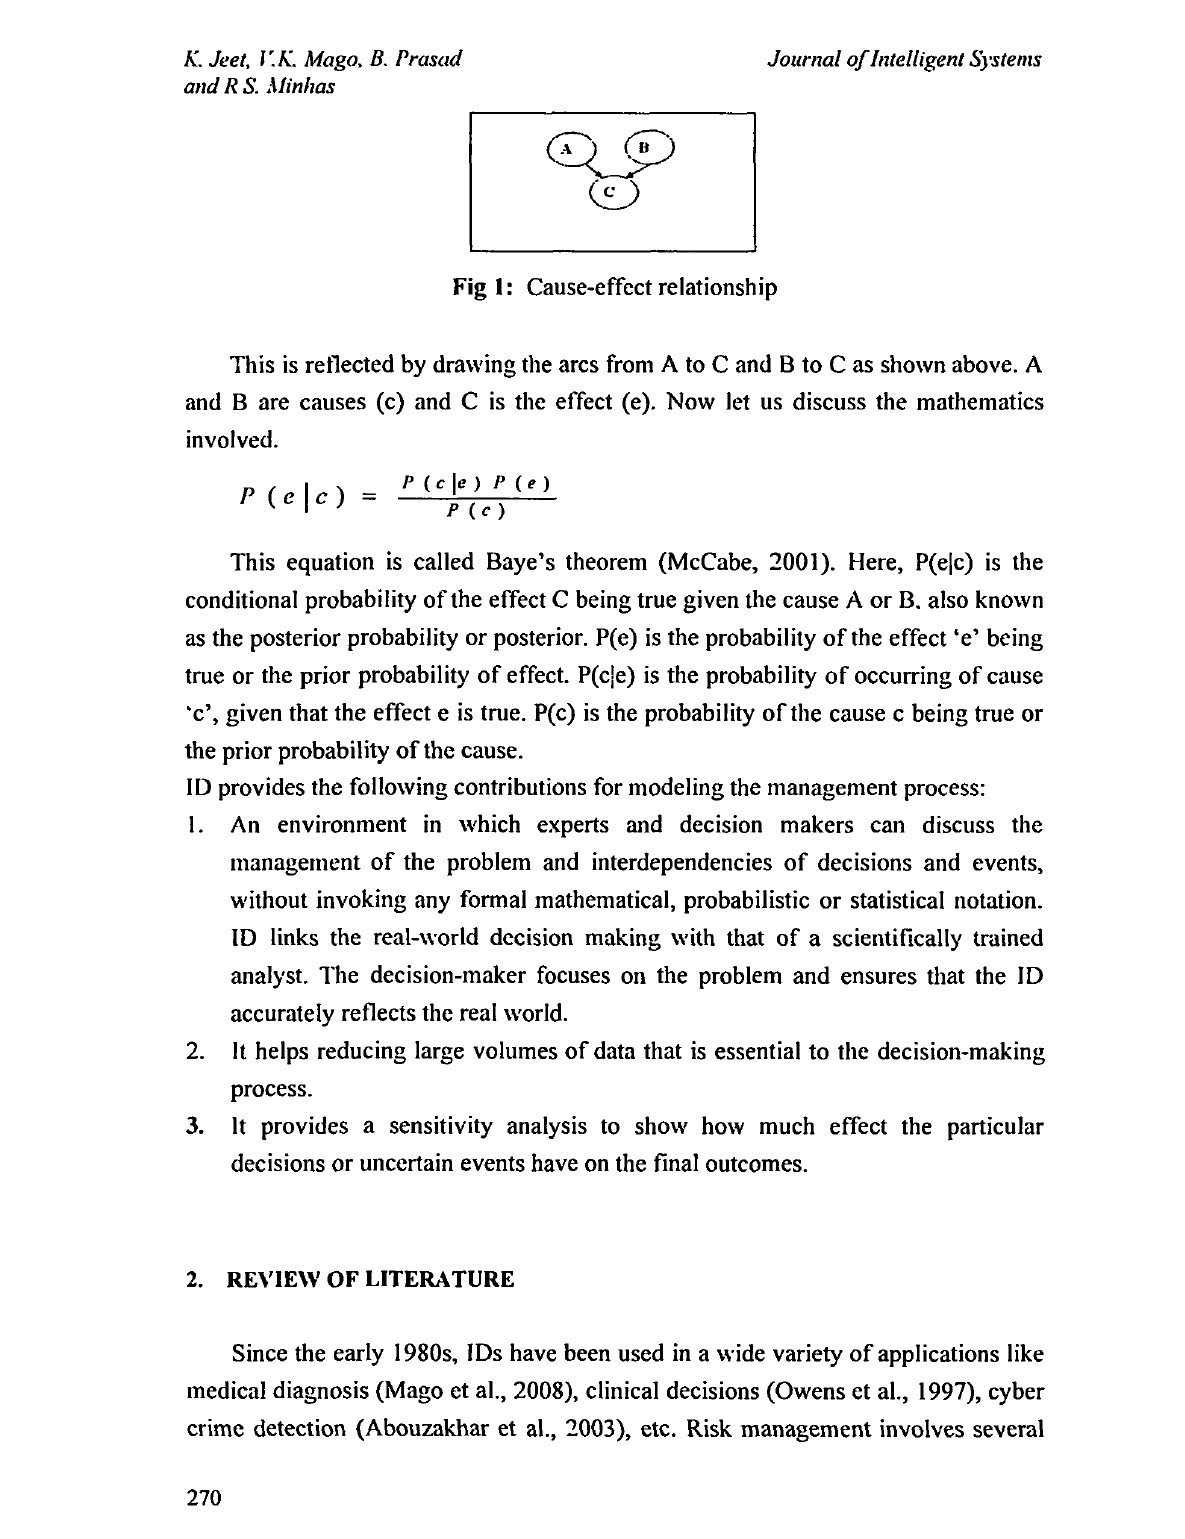
Fig I: Cause-effect